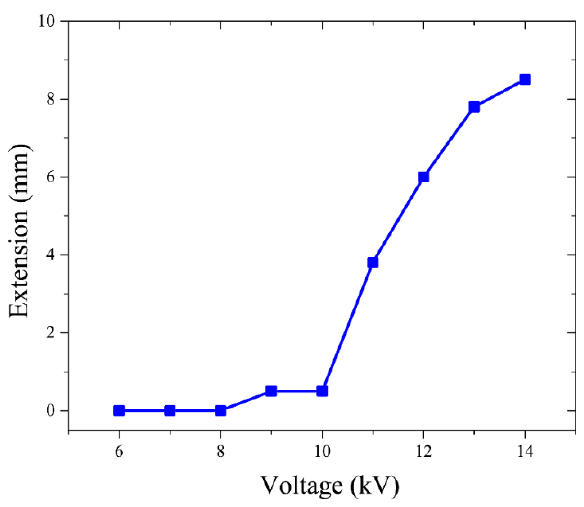
Figure 13. The extension response of the BSPA for different external voltages. The lowest threshold voltage of uncoiling motion was 10 kV, and the actuator flattened completely at 13.8 kV.